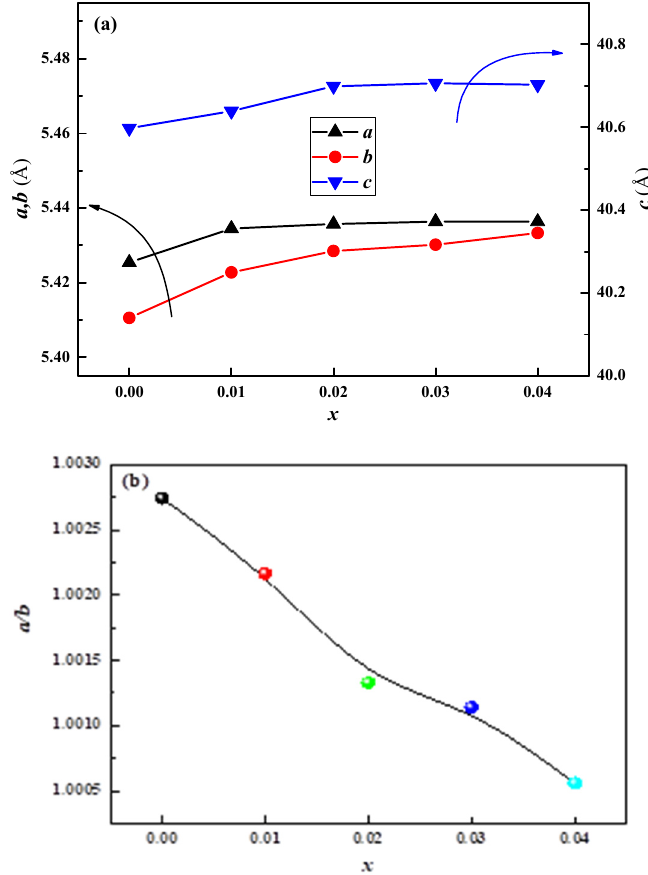
Figure 3. ( a ) Lattice parameters a , b , and c ; ( b ) a/b ratio of the Mn/Nb co-doped.